Question: Condense the content of this figure into a single sentence.
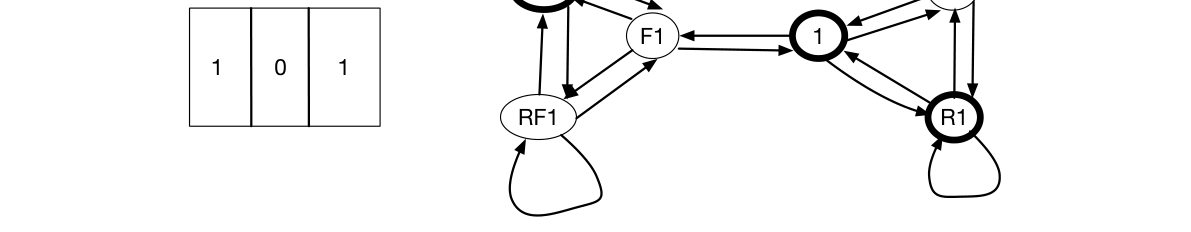
Answer: The state space for an n-bit register environment is 2n, but its diversity size is only 2n because there is one test for checking whether bit i is a 1 and another test for checking if bit i is a 0. In the 3-bit register environment shown here, 1 refers to a test that returns True if the leftmost bit is a 1. L, R, and F refer to input actions that rotate left or rotate right the entire register with wraparound, or flip the leftmost bit, respectively. The state 101 is represented by the tests LF1, 1, and R1 all returning True.